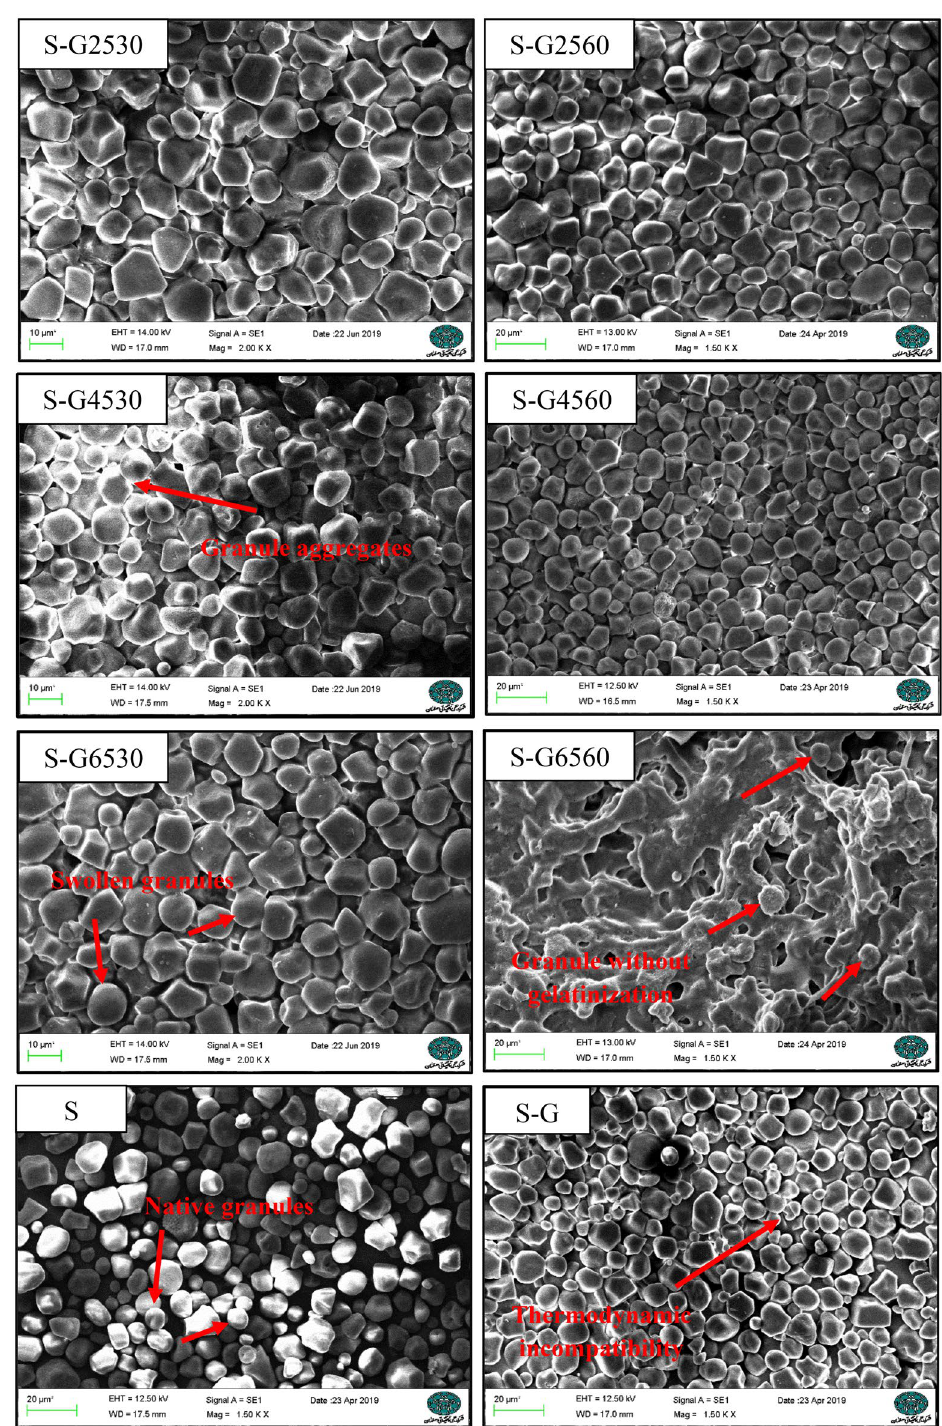
Figure 1. SEM micrographs of thermal-ultrasound treated corn starch-Arabic gum